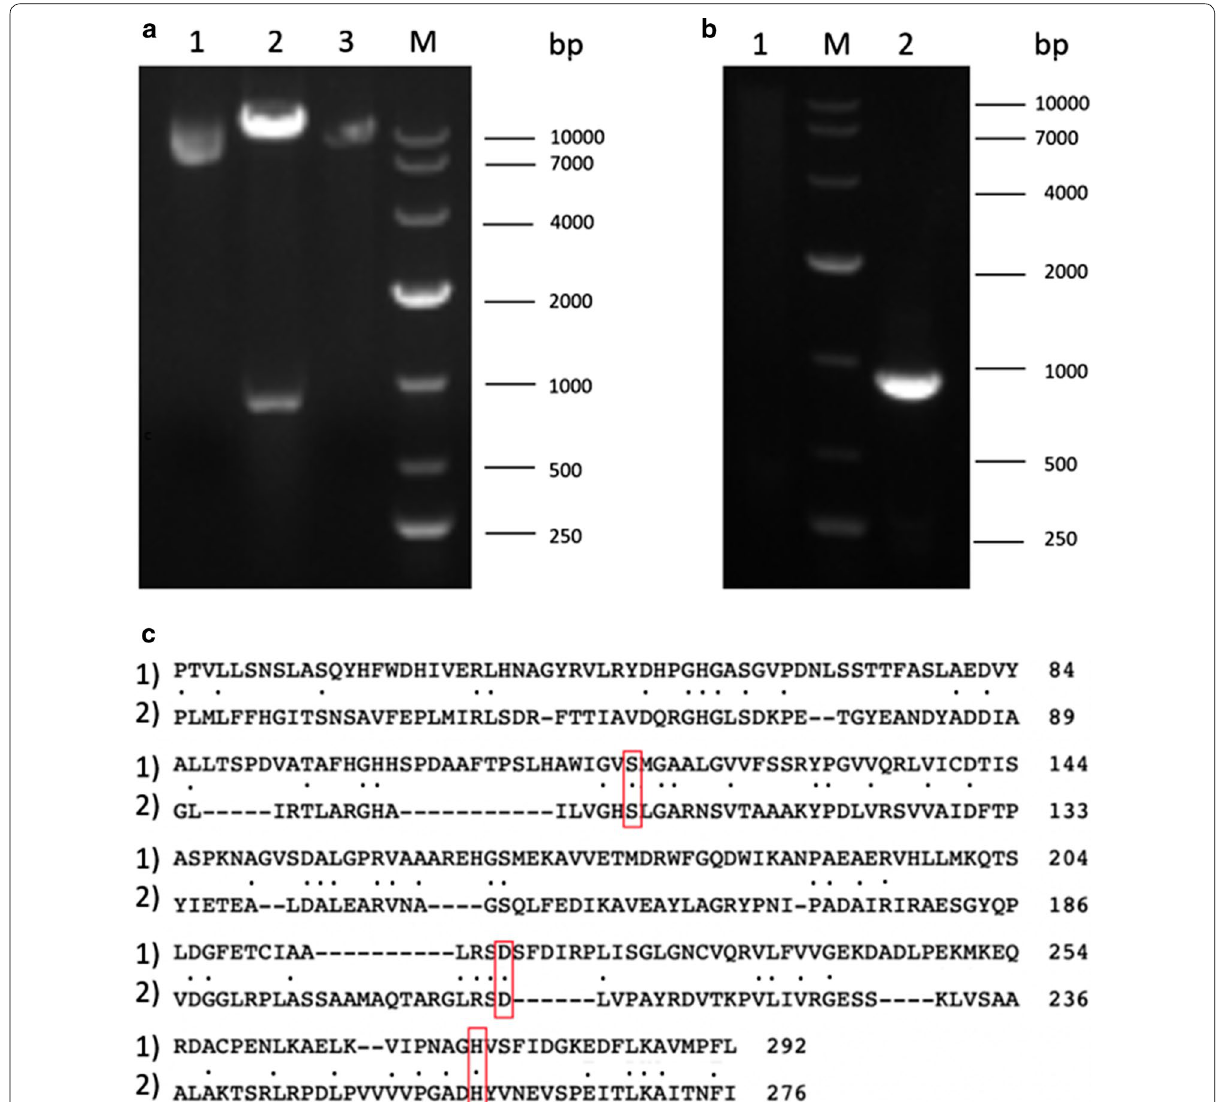
Fig. 1 a Electrophoresis analysis of expression plasmid. lane M: marker; lane 1: recombined plasmid; lane 2: recombined plasmid was digested by Eco RI and Not I; lane 3: pPIC9K was digested by Eco RI and Not I. b Electrophoresis analysis of PCR. lane M: marker; lane 1: PCR of P. pastoris ; lane 2: PCR of recombinant P. pastoris . c Alignment of the deduced amino acid sequence of ZENC (1, upper line) with 2-(acetamidomethylene) succinate hydrolase from Mesorhizobium japonicum (2, lower line). Identical (.) are shown. Residues that comprise the catalytic triad of a serine hydrolase